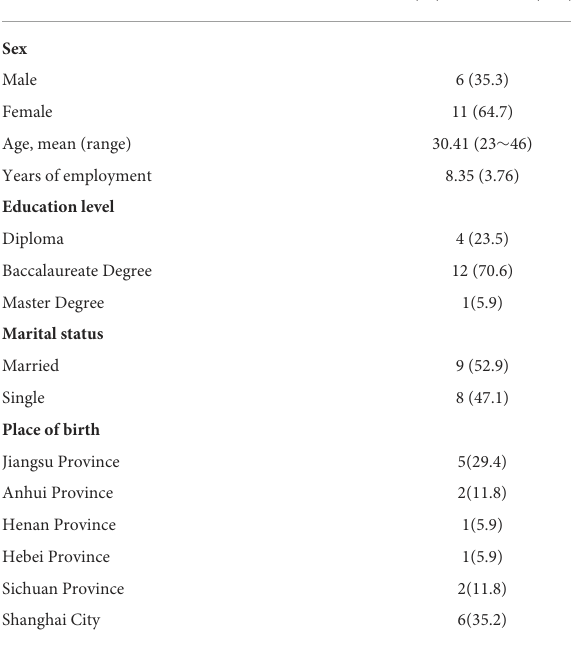
TABLE 1 Participant characteristics ( n =